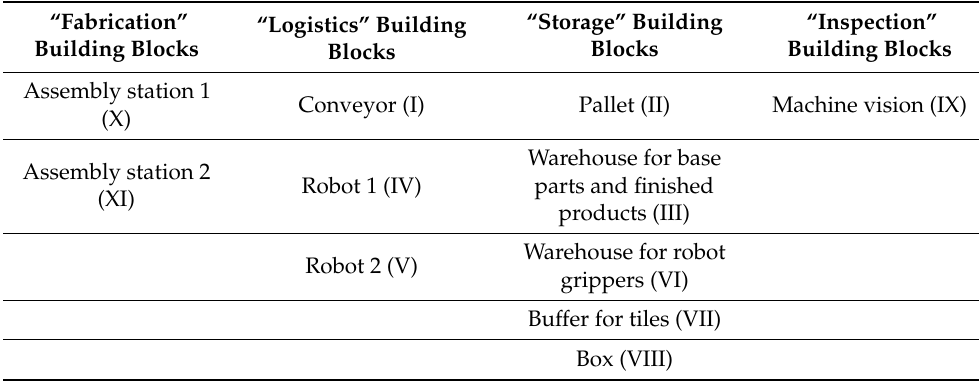
Table 2. Building blocks of the manufacturing system divided into the four